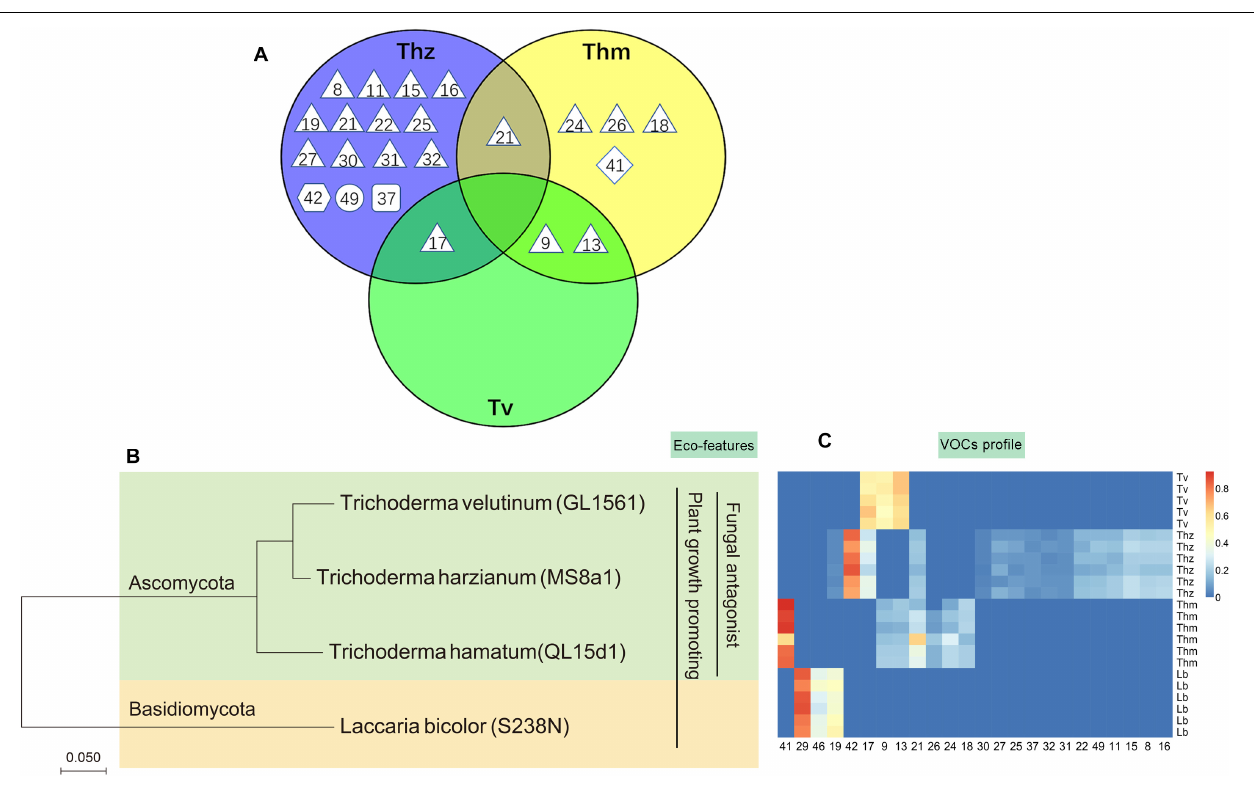
FIGURE 3 | Comparison of volatile organic compound profiles of T. harzianum (Thz), T. hamatum (Thm), and T. velutinum (Tv), and evolutionary relationship of the taxa. (A) Venn diagram depicting the VOC profiles of the Trichoderma species. Shape of the legend: diamond: monoterpene; hexagon: oxygenated monoterpene; triangle: sesquiterpene, square: oxygenated sesquiterpene; circle: other VOCs. The numbers refer to the compounds listed in Table 1 . (B) Evolutionary relationships of taxa presented in a phylogenetic tree. The evolutionary history was inferred using the neighbor-joining method (Saitou and Nei, 1987). (C) Heat map analysis of